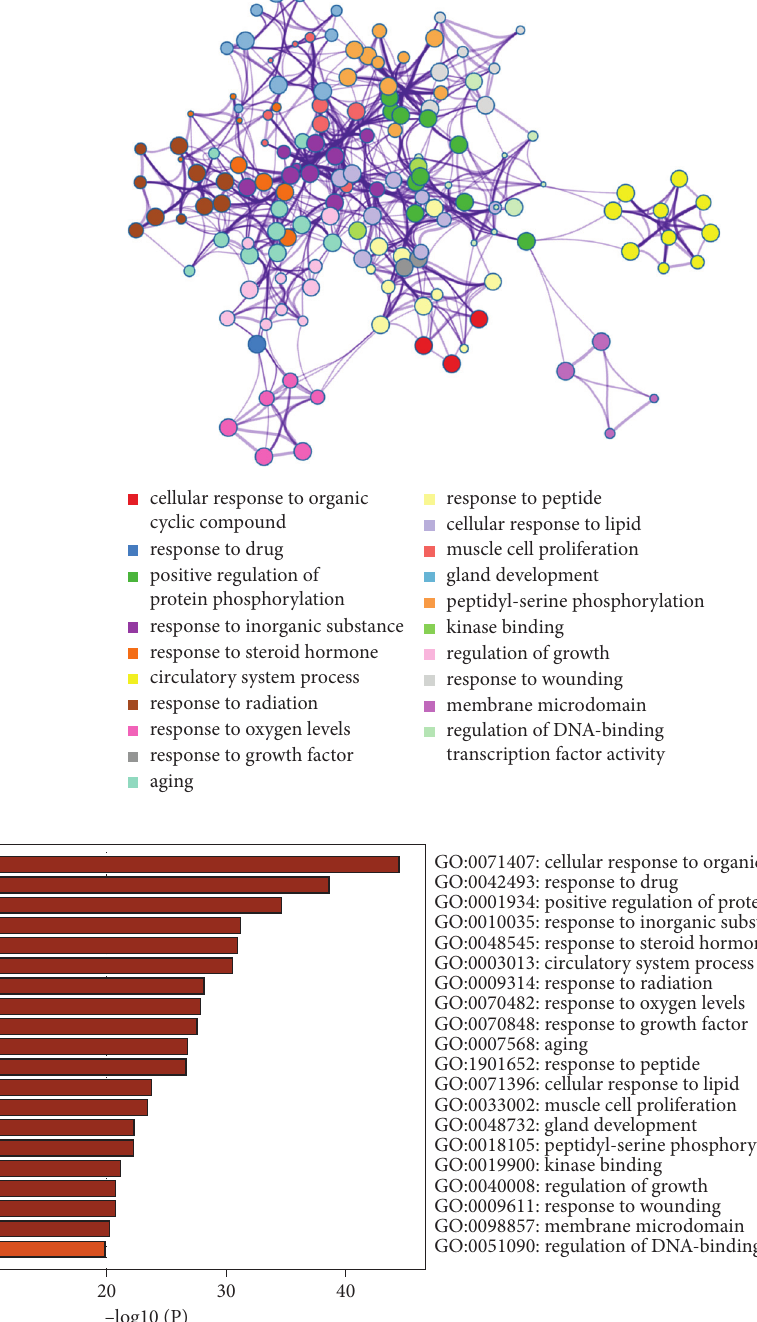
Figure 3: The GO enrichment